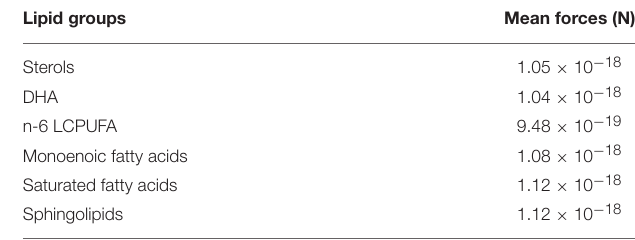
TABLE 1 | Data based estimation (Diaz et al., 2012) of the cylinders representing the modeled lipid membrane.